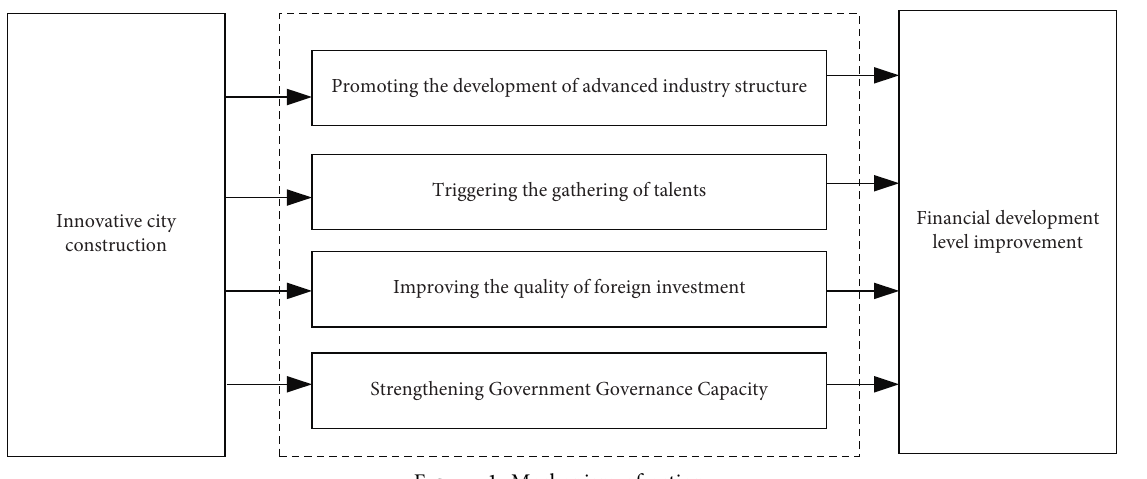
Figure 1: Mechanism of